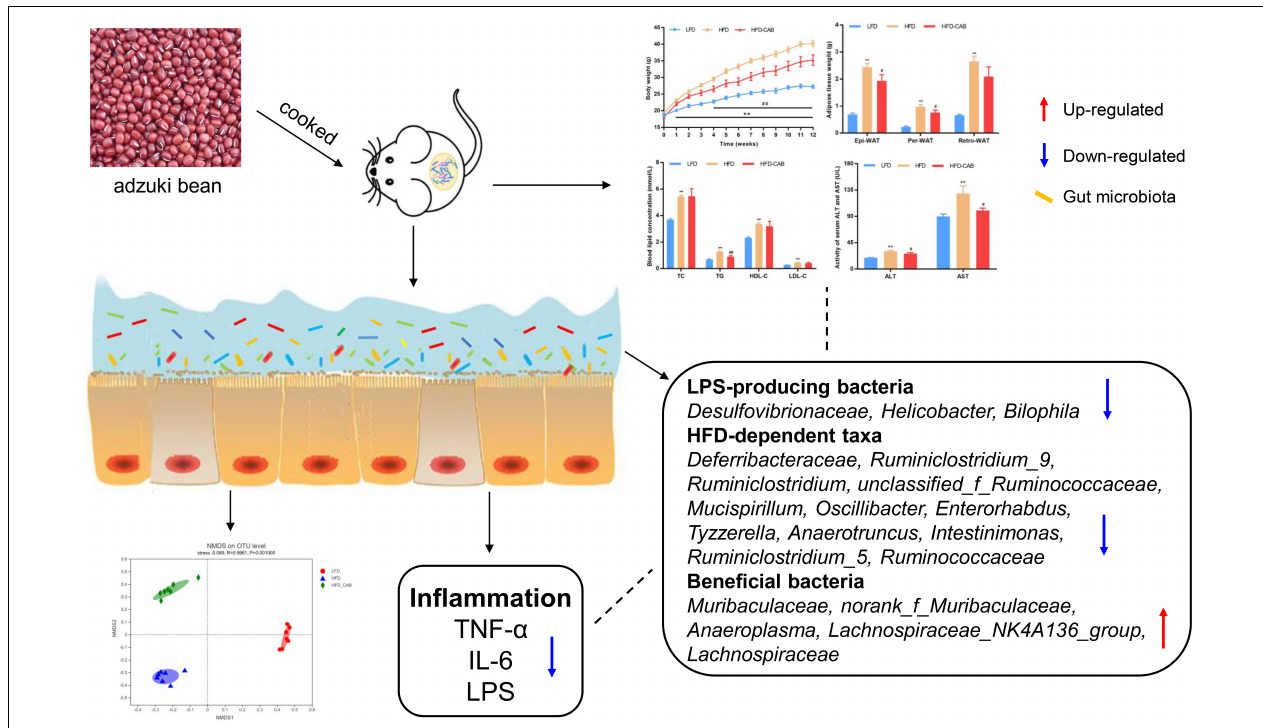
FIGURE 9 | Schematic representation of the anti-obesity effect of cooked adzuki bean via gut microbiota.